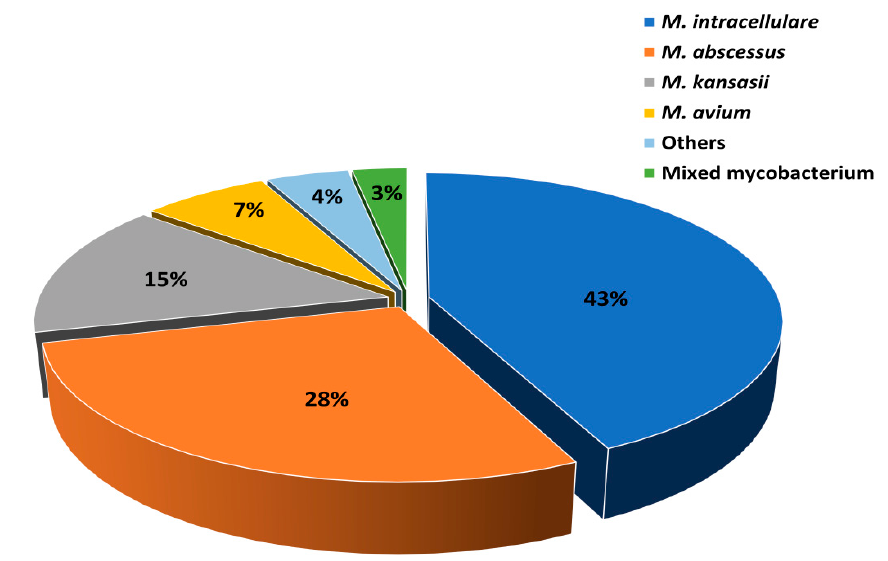
Figure 2. Abundances of different NTM species in patients diagnosed with NTMPD. NTM: nontuber- culous Mycobacteria, and NTMPD: nontuberculous mycobacterial pulmonary disease. Among all positive mycobacterial cultures from samples of sputum and BALF, the overall NTM positivity rate increased steadily over time (2014: 9.1%; 2015: 10.9%; 2016: 12.1%; 2017: 13.7%; 2018: 15.5%). We further analyzed the three most common NTM species (MAC, M. abscessus , M. kansasii ). From 2014 to 2018, there were steadily increasing percentages of patients with M. kansasii and M. abscessus infections, and a decreasing percentage of patients with MAC infections (Figure 3).